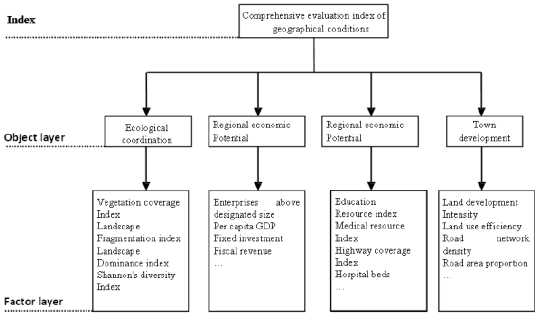
Figure 1. Three level evaluation system